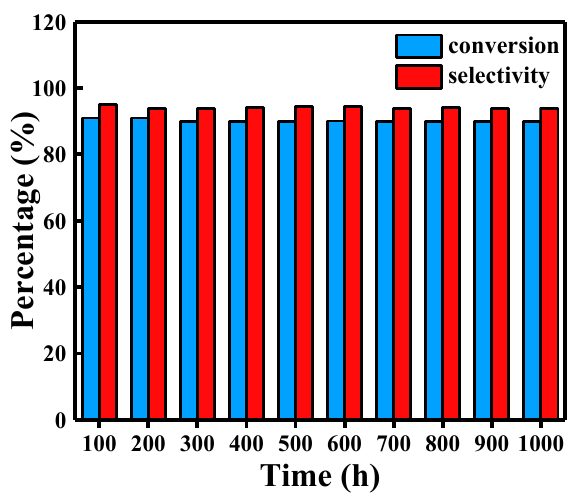
Figure 8. Catalyst life inspection in the trickle bed reactor. Reaction condition: Temperature: 110 °C, H 2 pressure: 2.5 MPa; Q injection = 1 mL/min; Q H2 = 10 mL/min; solution concentration: 5 wt% aqueous glucose.